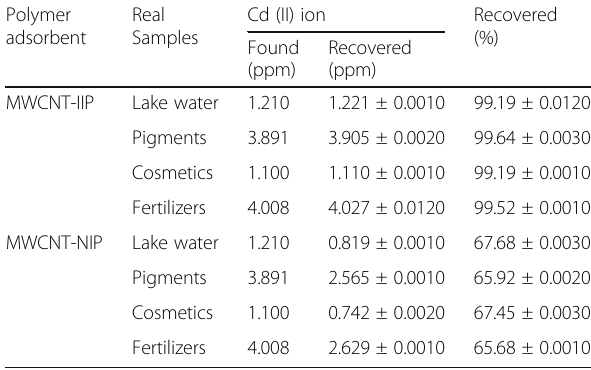
Table 5 Analysis of real